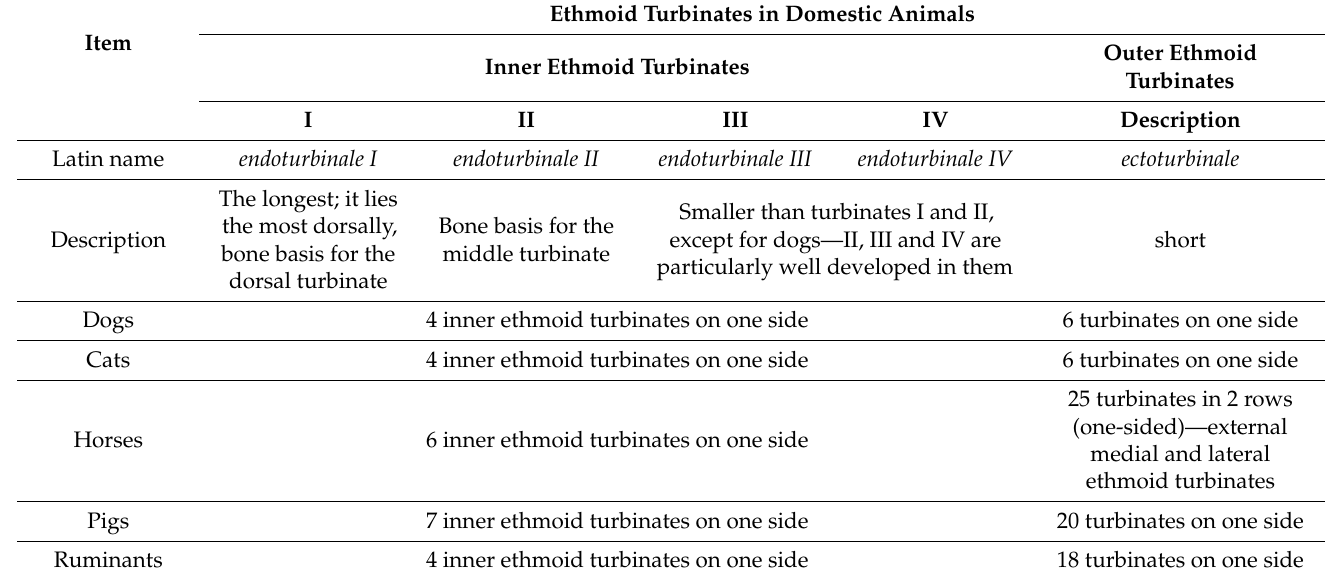
Table 1. Ethmoid turbinates in domestic animals based on literature